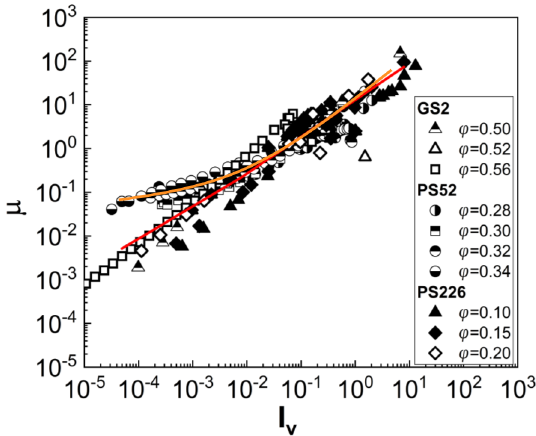
Figure 4. Macroscopic friction coe ffi cient ( µ ) of selected suspensions as a function of the viscous number. The continuous lines are guides to the eye for the two regimes of friction coe ffi cient values.